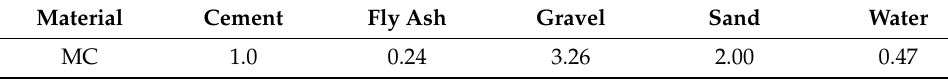
Table 2. Mix proportion of MC.